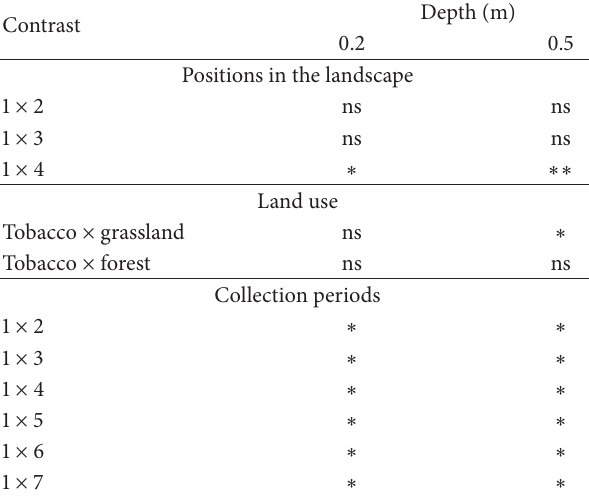
Table 4: Orthogonal contrasts for nitrate concentrations in soil solutions between different positions in landscape, between collec- tion times, and between land uses.